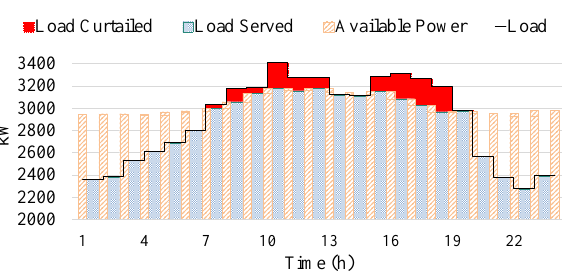
Figure 12. Effect of the proposed DR method on the network.